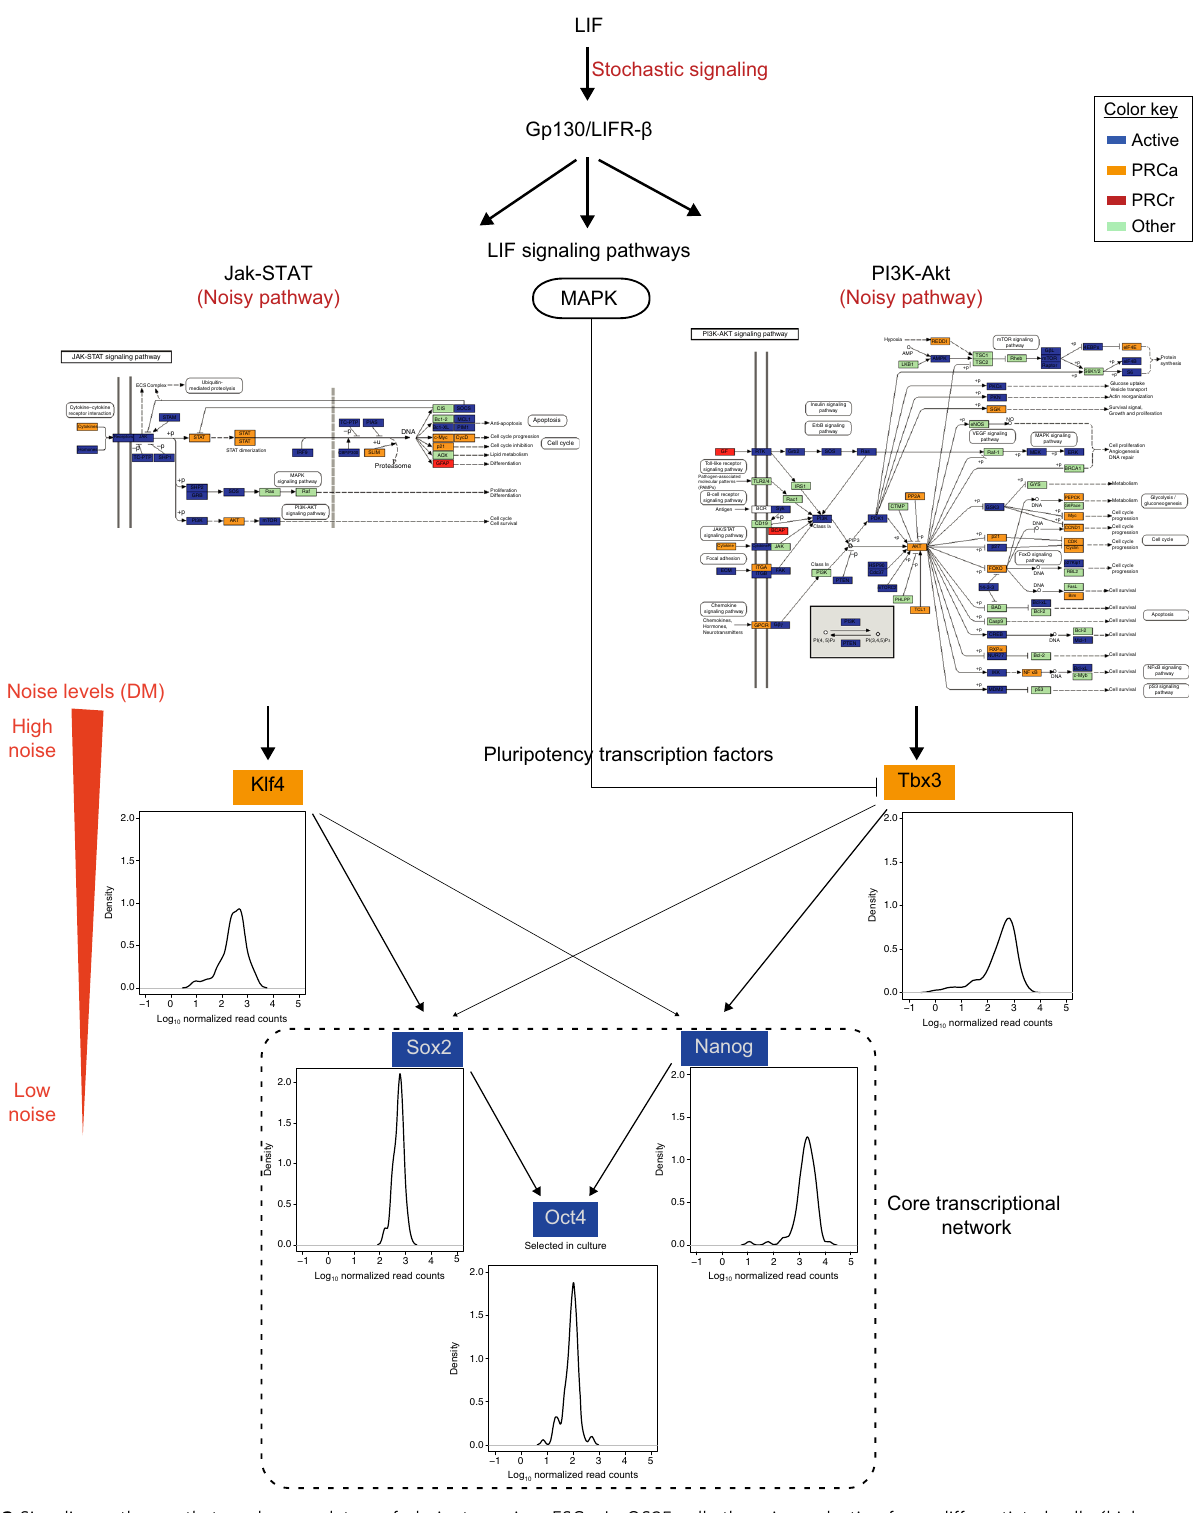
Fig. 3 Signaling pathways that are key regulators of pluripotency in mESCs. In OS25 cells there is a selection for undifferentiated cells (high Oct4 -expressing). LIF integrates signals into the core regulatory circuitry of pluripotency ( Sox2 , Oct4 , and Nanog ) via two signaling pathways: Jak-Stat and PI3K-Akt 22 . The Jak-Stat pathway activates Klf4 , and the PI3K-Akt pathway stimulates the transcription of Tbx3 , which are both PRCa genes. The MAPK pathway antagonizes the nuclear localization of Tbx3 . PRCa genes are enriched in Jak-Stat and PI3K-Akt pathways, which show high cell-to-cell variation, suggesting a crucial role of PRCs in modulating fl uctuations in signaling pathways that integrate LIF signals into core transcription factor network (Figure adapted from ref. 22